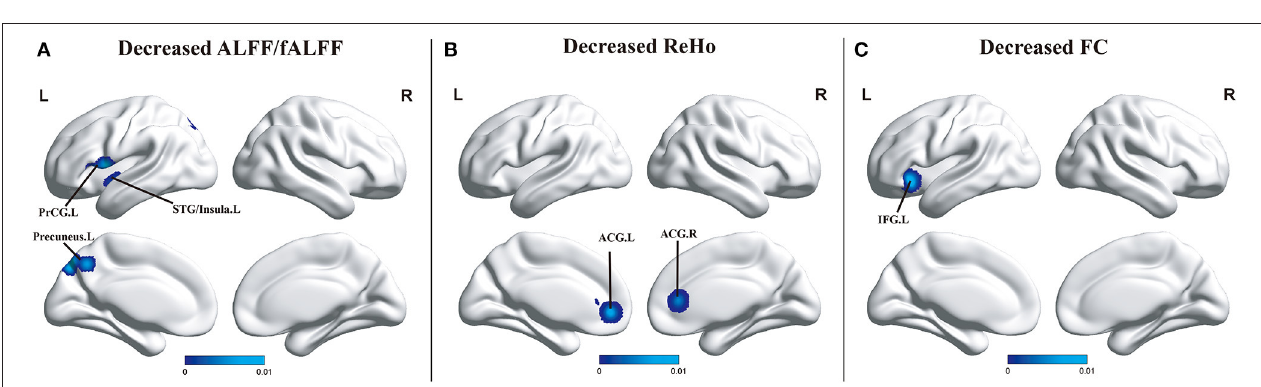
FIGURE 3 | (A) Brain regions showing decreased ALFF/fALFF in patients with aMCI compared with HCs. (B) Brain regions showing decreased ReHo in patients with aMCI compared with HCs. (C) Brain regions showing decreased FC in patients with aMCI when compared with HCs. The color bar represents the p -value. Areas with decreased change relative to controls are displayed in blue, and areas with increased change are displayed in red. Results are thresholded at p < 0.01 cluster-corrected and p < 0.05 family-wise error corrected. Abbreviations: aMCI, amnestic mild cognitive impairment; HCs, healthy controls; ALFF/fALFF, the amplitude of low-frequency fluctuation/fractional amplitude of low-frequency fluctuation; ReHo, regional homogeneity; FC, functional connectivity; ACG, anterior cingulate gyrus; PreCG, precentral gyrus; STG, superior temporal gyrus; IFG, inferior frontal gyrus; R, right; L,